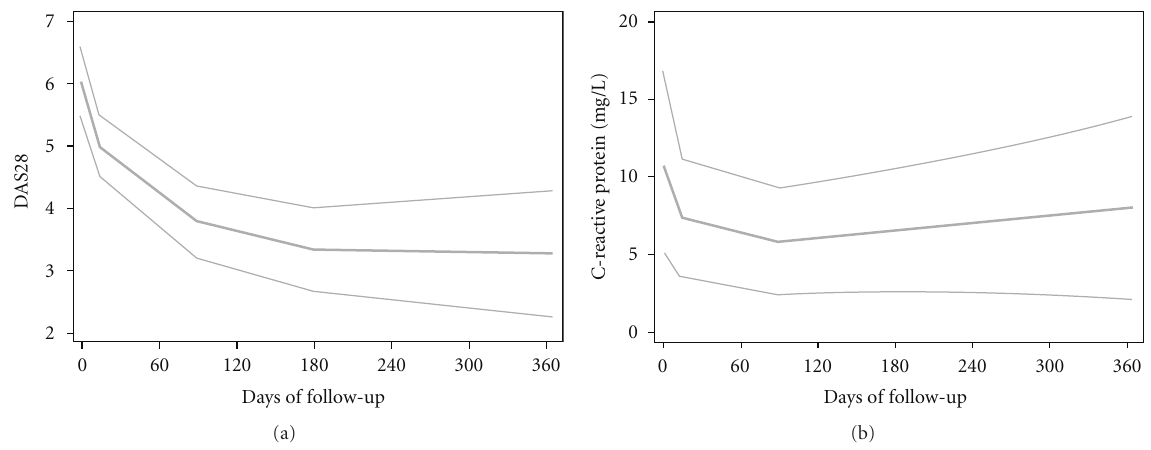
Figure 1: Changes in DAS28 (a) and C-reactive protein (b) from day 0 onwards, obtained via locally weighted regression. Central estimate and lower and upper limits of 95% confidence